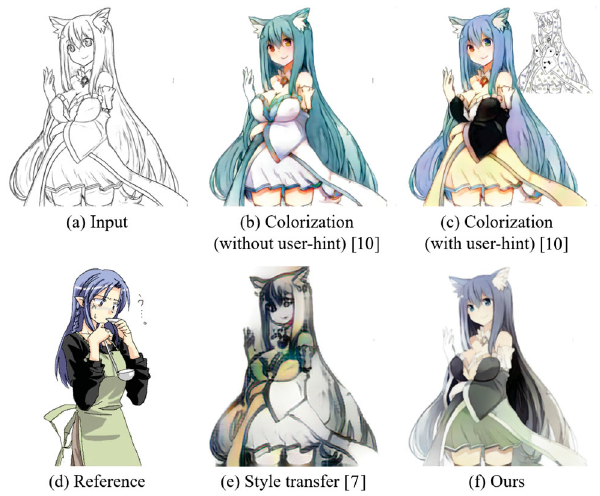
Fig. 1 Comparison between our method and existing sketch colorization and style transfer